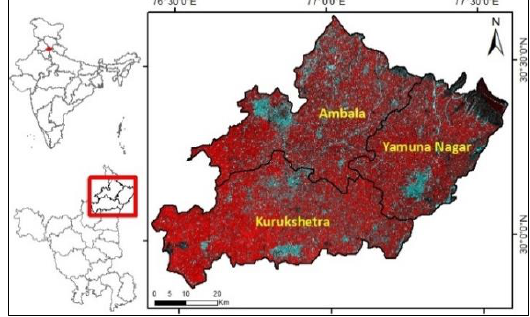
Figure 1. The study area Ambala, Kurukshetra